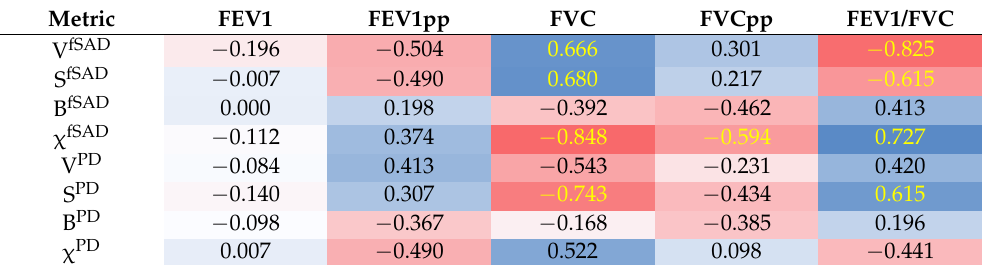
Table 2. Correlations of whole lung tPRM metrics of dominant phenotypes to pulmonary function